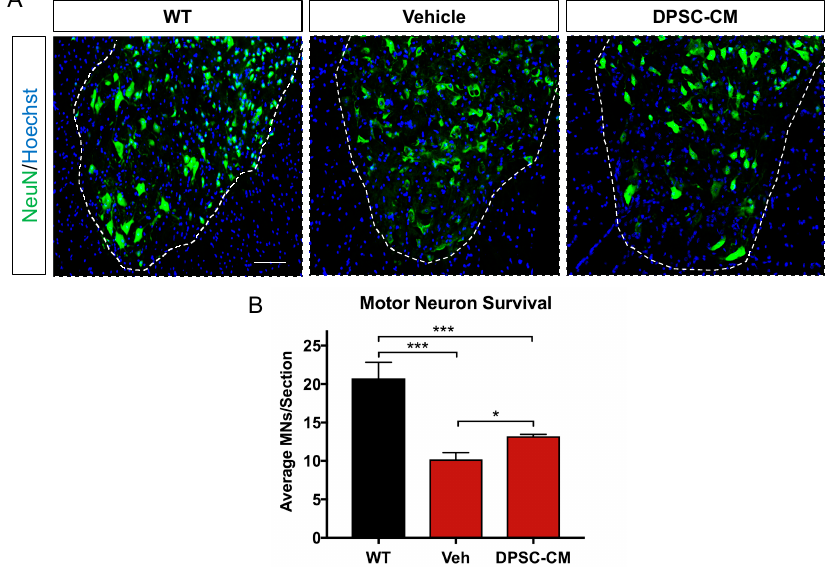
Figure 4. Late pre-symptomatic DPSC-CM treatment in mSOD1 G93A mice significantly attenuated ventral horn MN loss. Daily systemic DPSC-CM treatment from PD70–91 significantly increased MN survival in the mSOD1 G93A mouse lumbar spinal cord ventral horn compared to vehicle treatment, as measured by NeuN + cells (green) in the ventral horn. Motor neurons in both Vehicle (Veh) and DPSC-CM treated mSOD1 G93A mice were significantly less than those in wild-type (WT) mouse lumbar spinal cord. Blue labeling indicates cell nuclei. Data represent mean +/ − SEM. Data analyzed via one-way ANOVA. (WT, n = 3; mSOD1 G93A , n = 5–6). *, p < 0.05; ***, p < 0.001. Scale bar = 150 μ m.